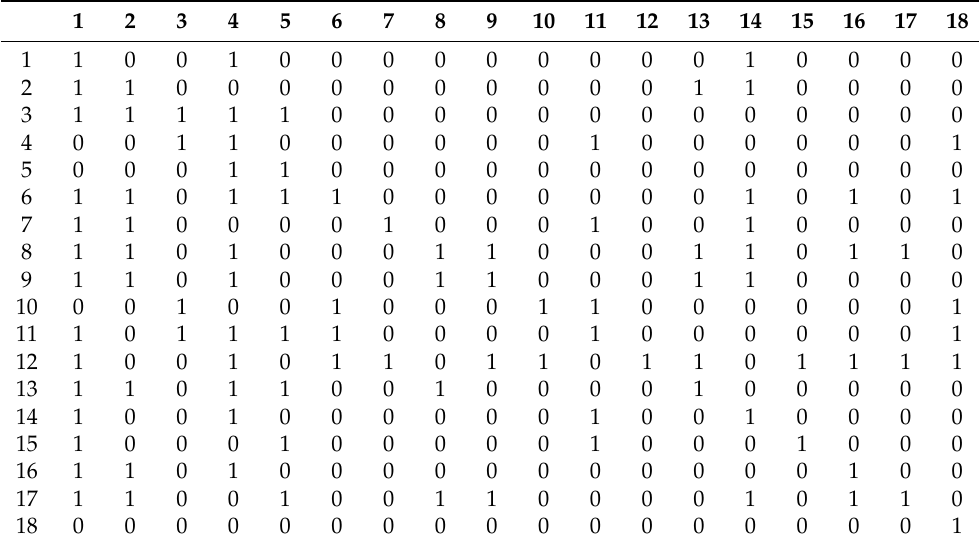
Table 4. Initial reachability matrix.